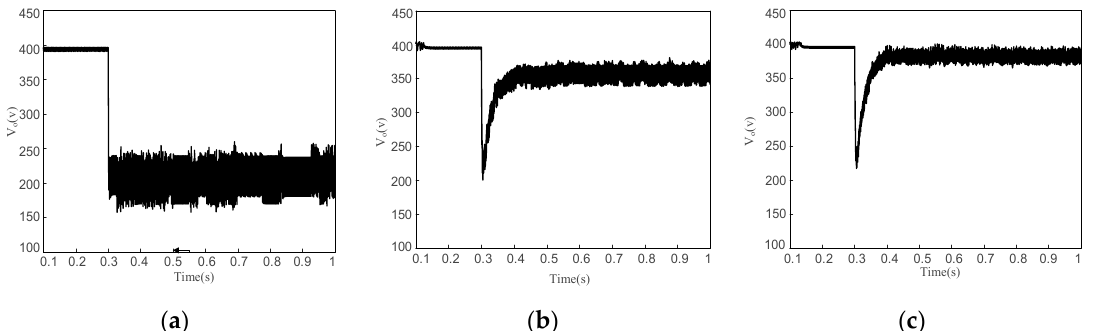
Figure 9. Waveforms of bus voltage with ( a ) Traditional Droop Control; ( b ) Nonlinear Droop Control